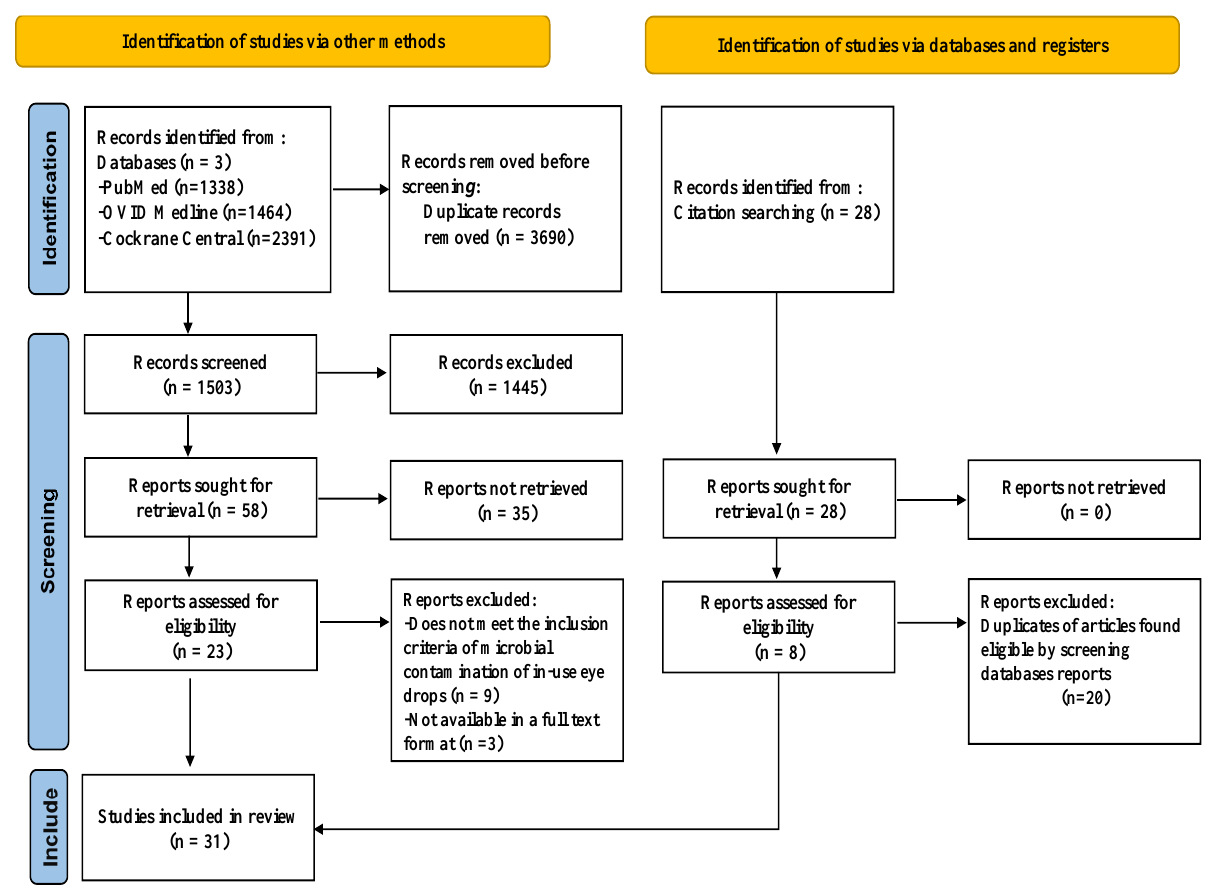
Figure 2. PRISMA flow diagram of the search.